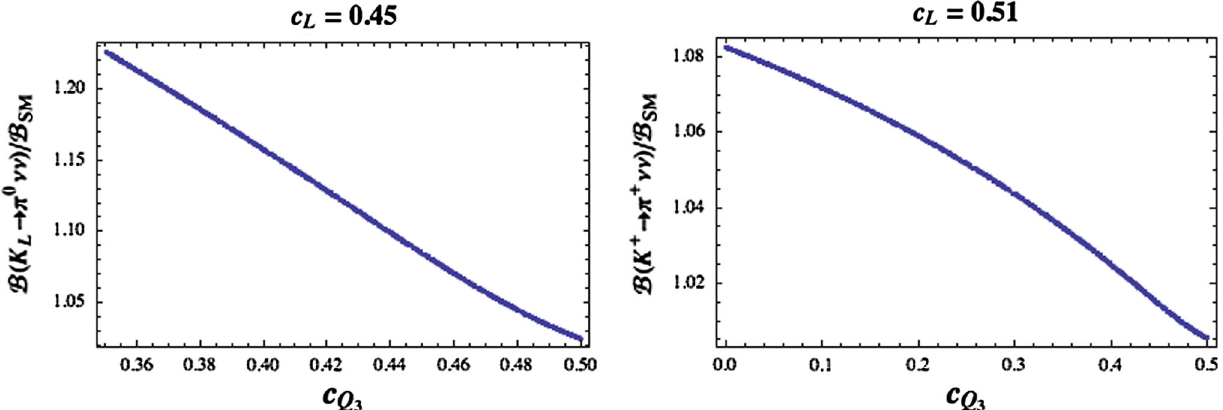
Fig. 7 Scenario A: plots depicting the excess over the SM expectation for the K decays modes. The c parameters for the doublets is universal and chosen to be c L = 0 . 51